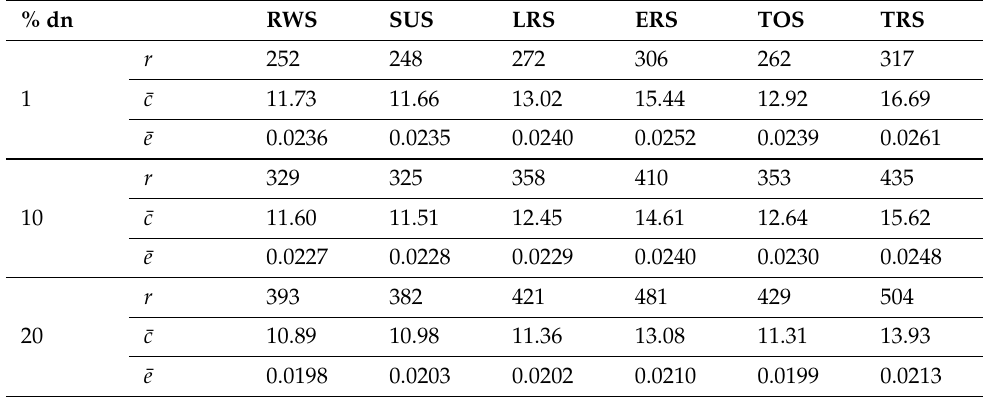
Table 4. Numerical simulation